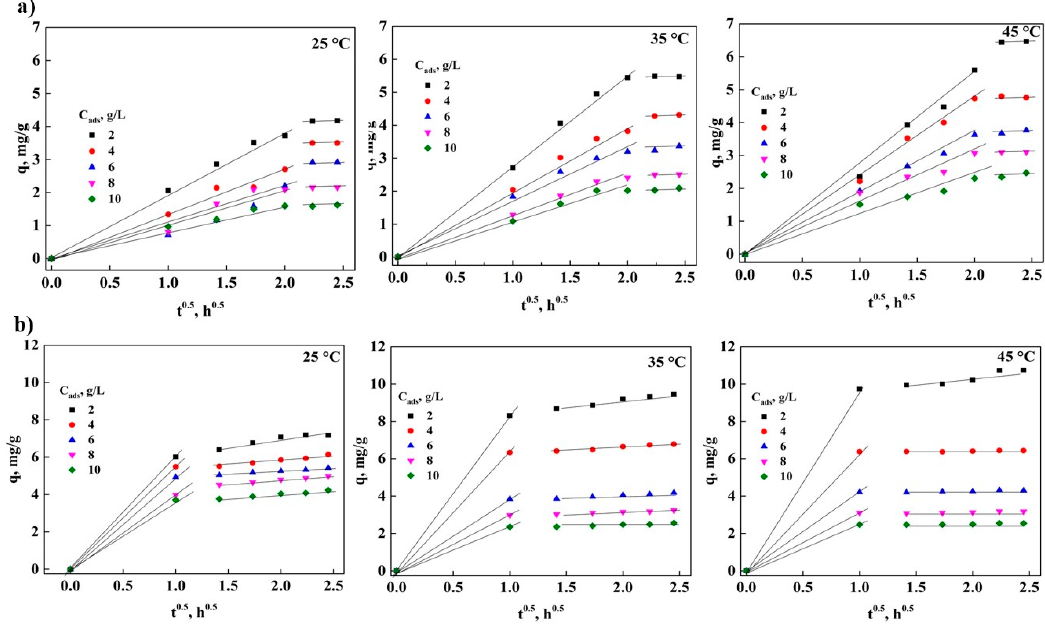
Figure 5. External mass transfer analysis at different temperatures: ( a ) GAC and ( b ) PAC.